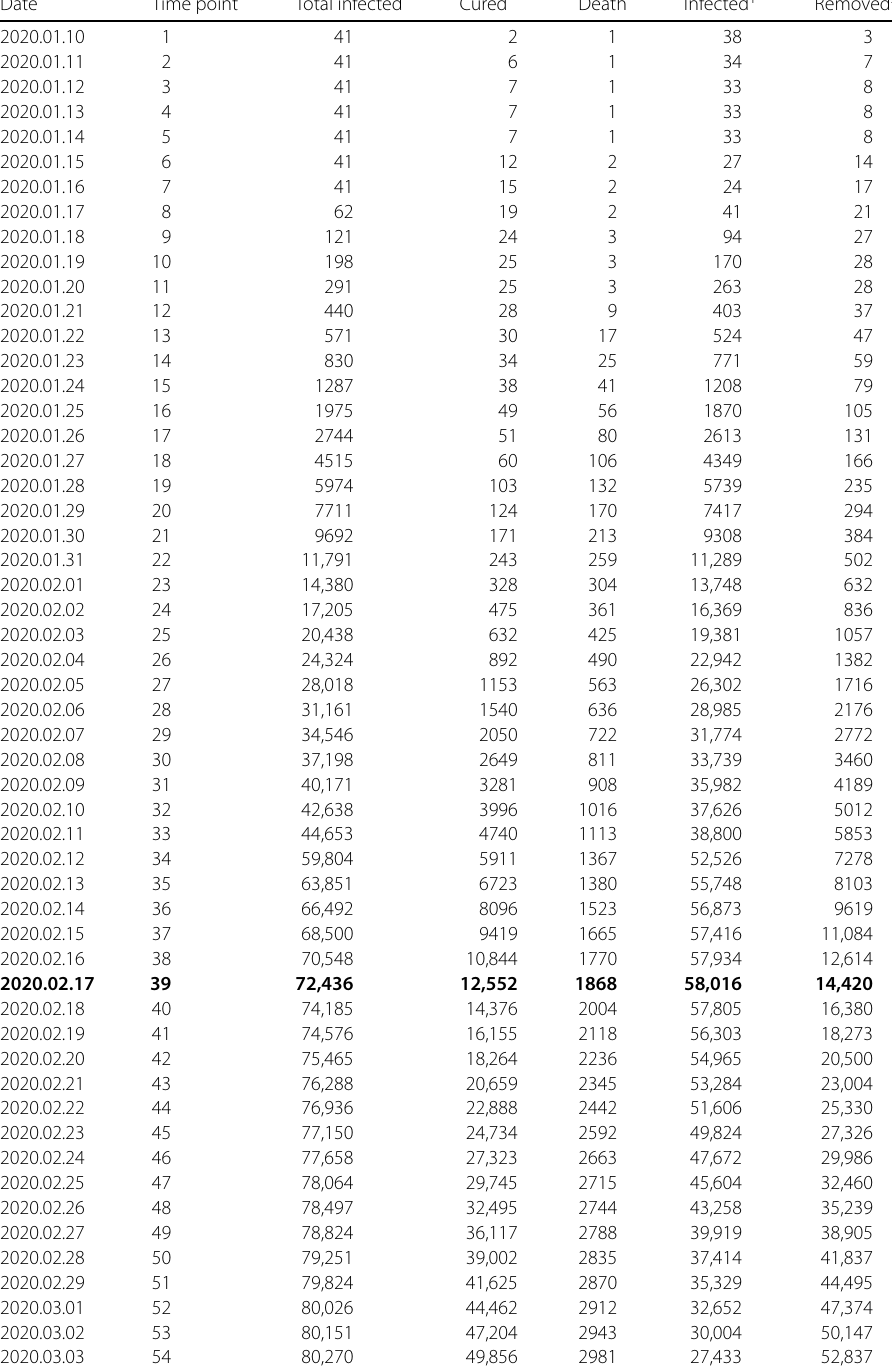
Table 1 The number of the infected, cured, deaths and